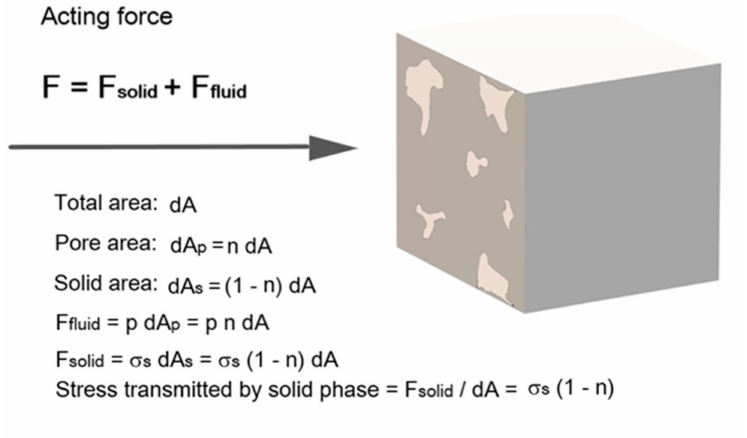
Figure 2. Fillunger’s interpretation of ES. According to such model, the ES is viewed as the force per unit (porous) area borne by the only solid